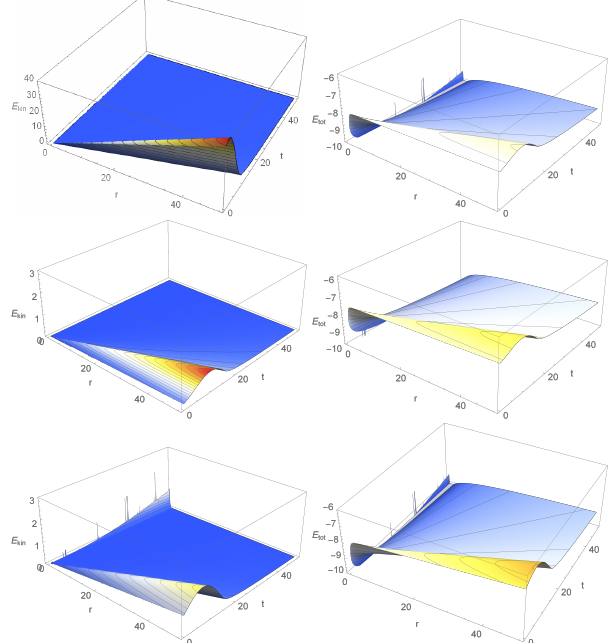
Figure 6. The first column presents the kinetic energies and the second is for the total energies calculated with different initial velocities for the same initial density of g ( 10 − 3 ) = 10 − 1 , and for w = − 1. The five following rows show the corresponding physical quantities for f ( 10 − 3 ) = − 0.5, 0, and 0.5 initial velocities,